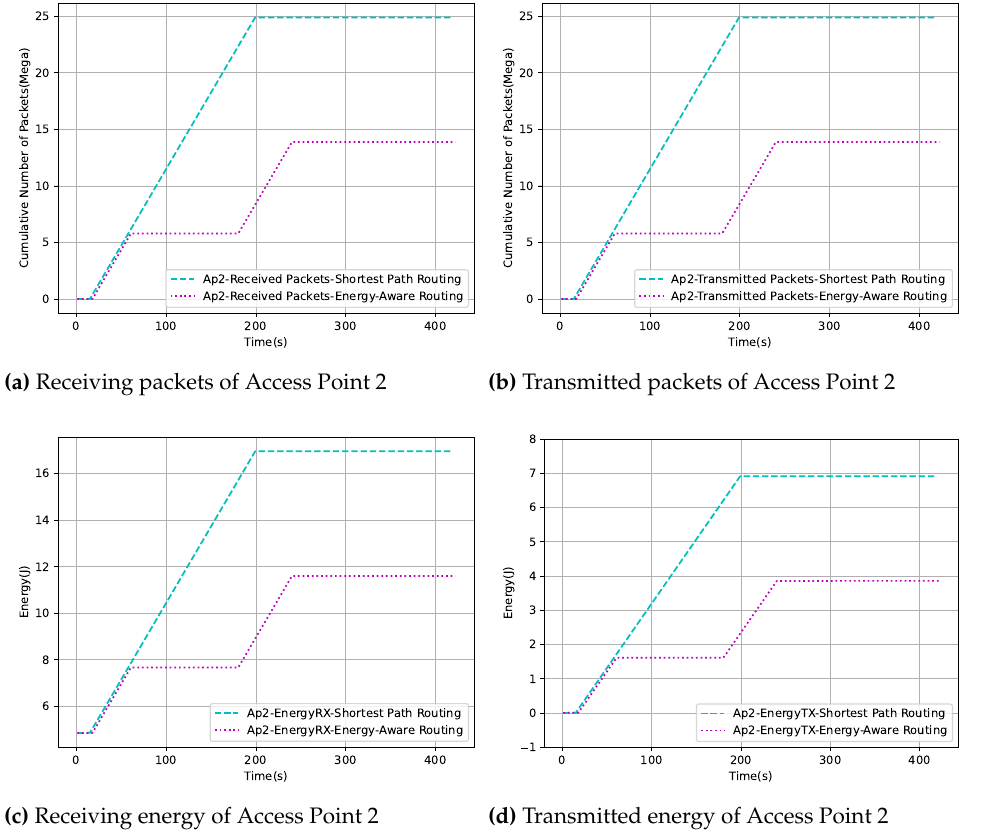
Figure 11. Cumulative Packets and Energy of Access Point